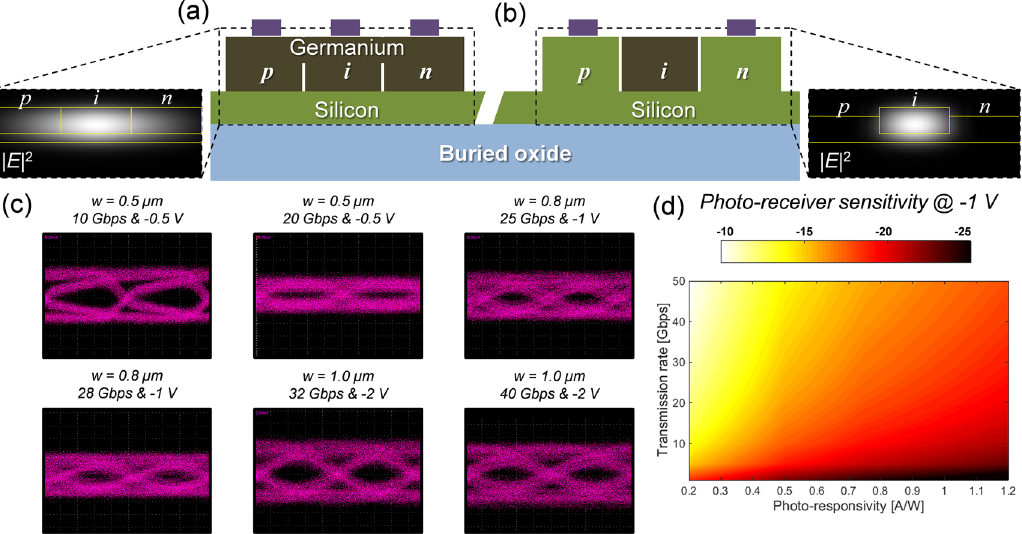
Figure6: Lateralp-i-nphotodetectorsin(a)Gehomo-junctionand(b)Si – Ge – Sihetero-junctionconfigurations.Insets:Opticalfieldprofilesof the fundamental quasi-transverse electric modes in both types of structures. (c) Eye diagram apertures of various Si – Ge – Si p-i-n photode- tectors with a lateral hetero-junction operated under low-biases and different bit rates. (d) Estimated receiver sensitivity with hetero-junction Si – Ge – Si photodetectors operated at − 1 V, for a 1.55 µm wavelength and different transmission bit rates. The minimum detected power is de fi ned at 10 − 12 BER, considering a TIA with an equivalent noise current density of 15 pA/Hz 1/2